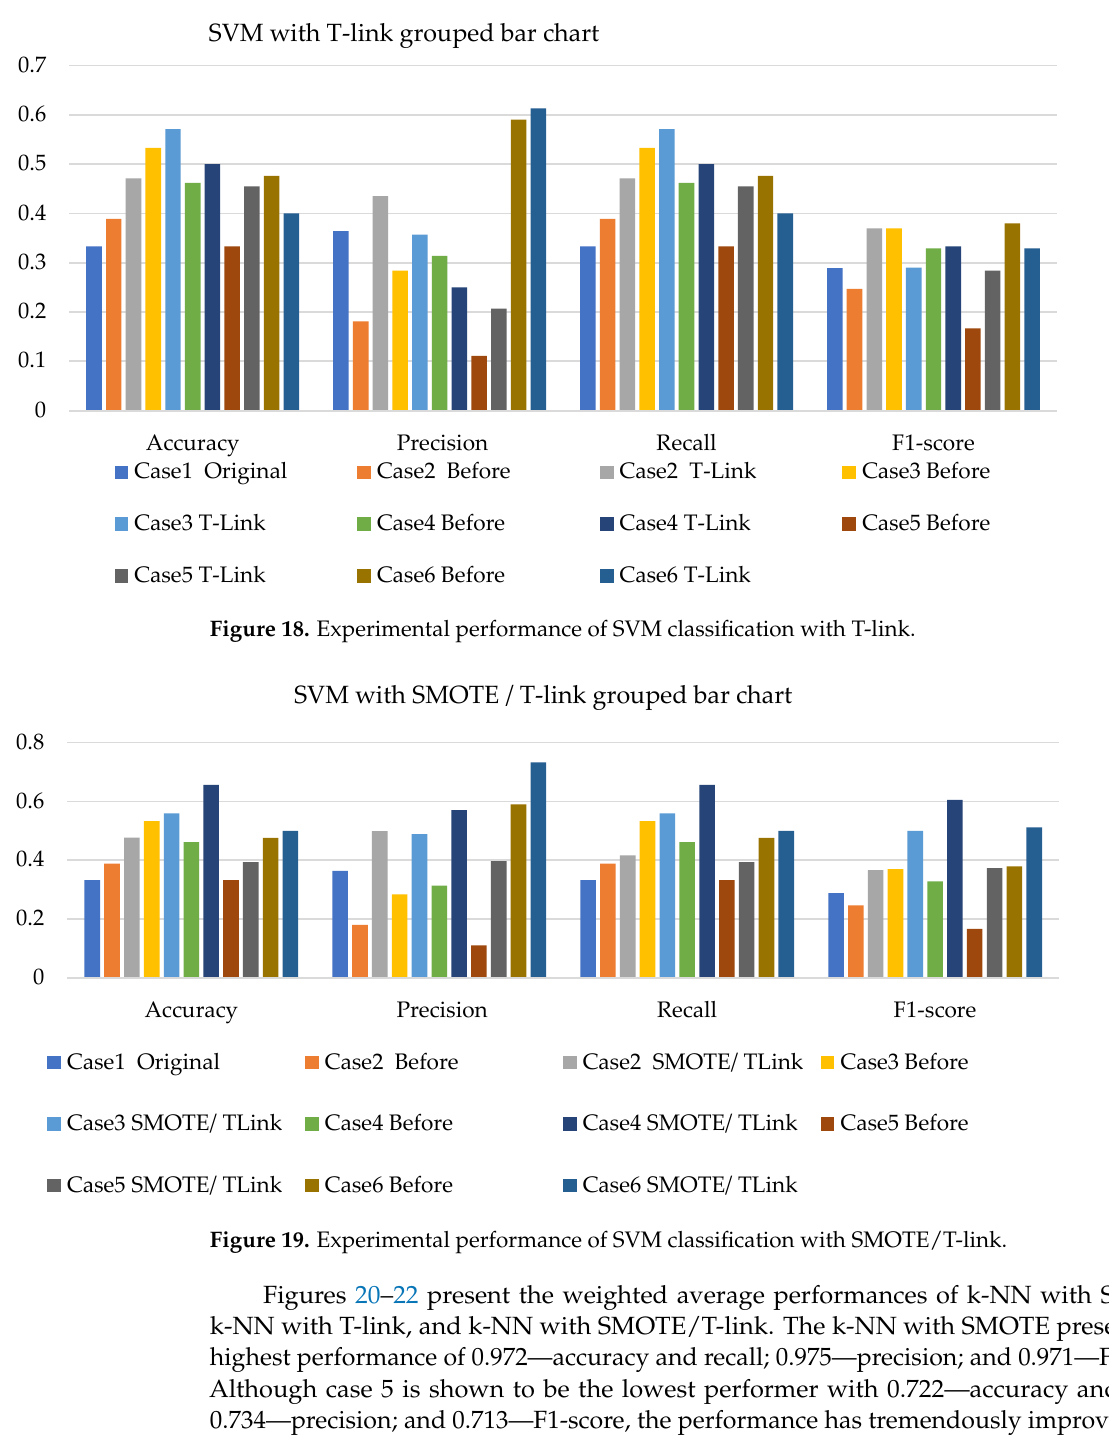
Figure 20. Experimental performance of k-NN classification with SMOTE.